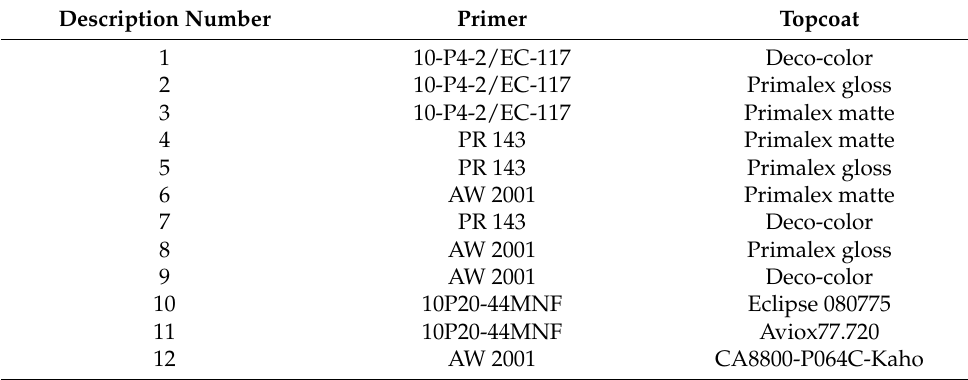
Table 3. Combinations of primers and